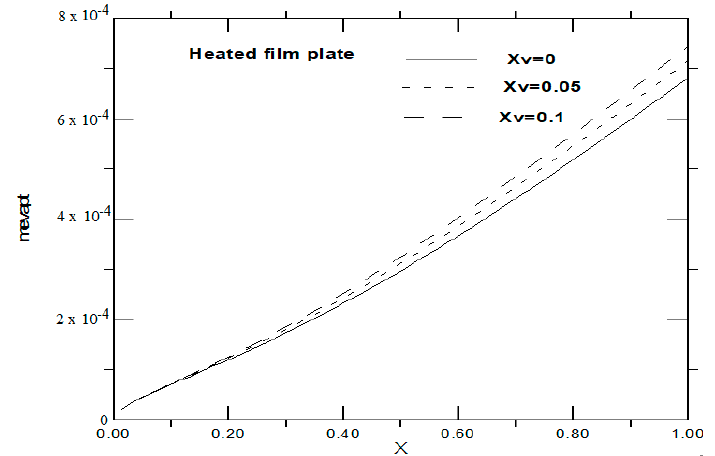
ff ect of the nanoparticle volume rate on the total evaporation rate-heated plate Figure 6. Effect of the nanoparticle volume rate on the total evaporation rate-heated plate case. Figure 6. E Figure 6. Effect of the nanoparticle volume rate on the total evaporation rate-heated plate case. Figure 6. Effect of the nanoparticle volume rate on the total evaporation rate-heated plate case.